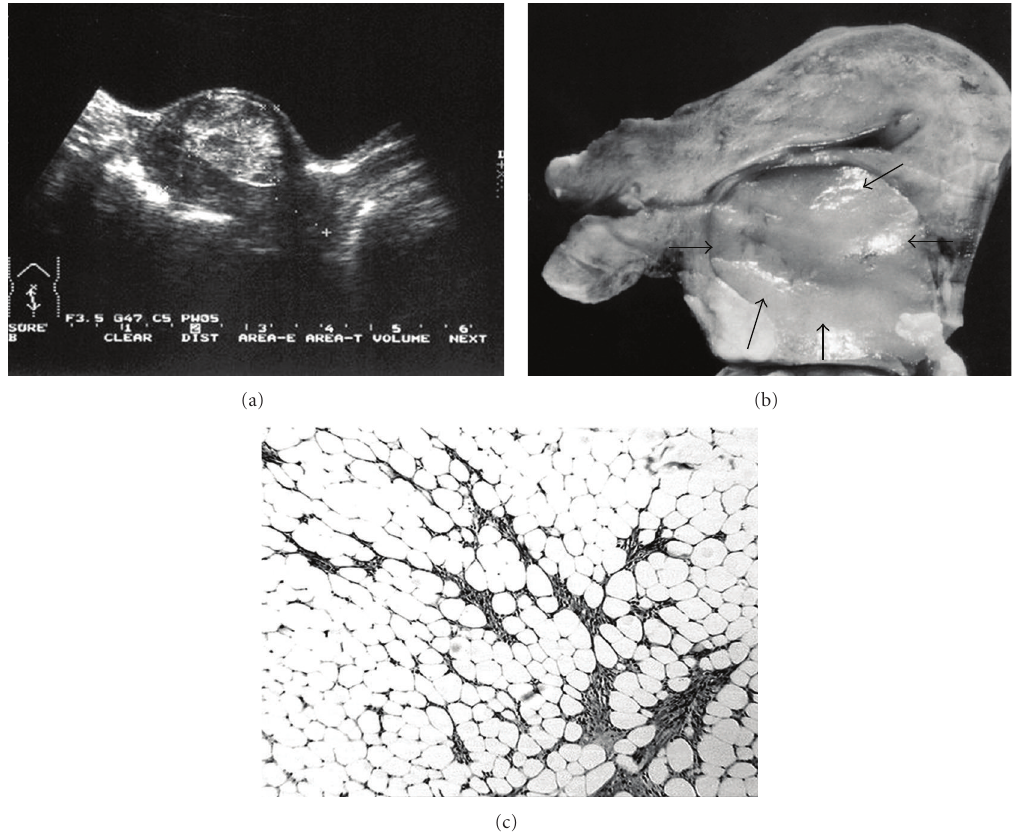
Figure 1: (a) Suprapubic ultrasound study with full bladder (+). Longitudinal cut of the uterus with a well-defined nodular lesion (arrows), intramural and hyperechogenic on the anterior uterine face. (b) Surgical resection piece: anteroposterior surface cut. Presence of a well- defined intramural nodular lesion in the anterior face with a surface that is homogeneous, bright, and yellowish in colour (arrows). An endometrial polyps can also be seen in the uterine fundus. (c) Microscopic image of the uterine lipoma. Solid masses of mature adipocytes occasionally delimited by fibroconnective tracts with capillary vessels. Hematoxilin-eosin,